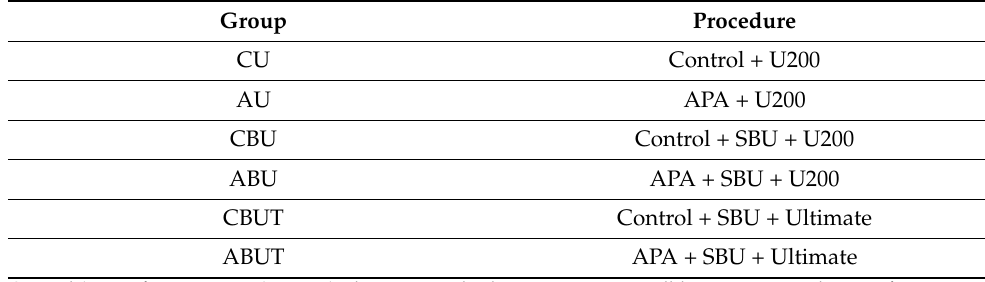
Table 2. Description of study groups and respective adhesion